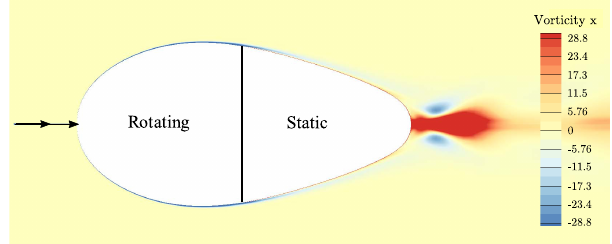
Figure 8. Vorticity in the stream-wise direction in the boundary layer of an isolated nacelle including only the spinner and the static rear